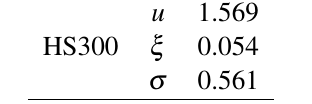
Table 3 POT Model Estimation